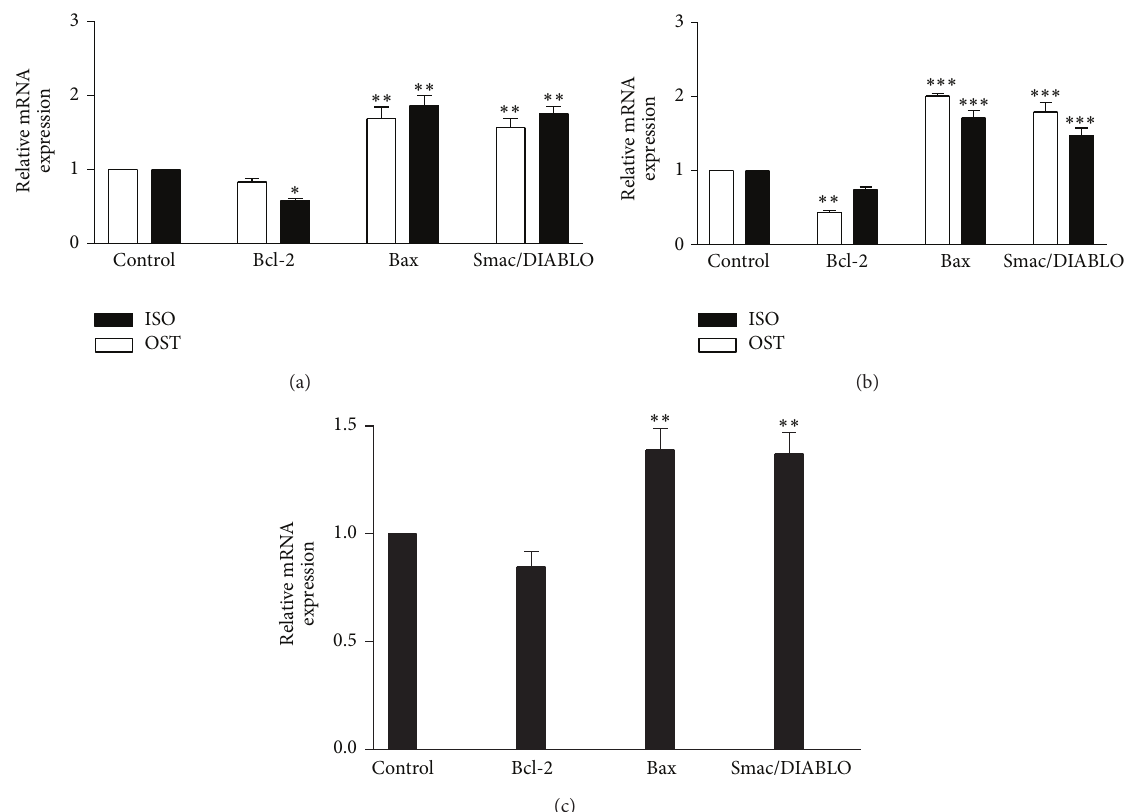
Figure 4: The effect of coumarins on expression of apoptotic-related genes on (a) SKNMC, (b) PC3, and (c) H1299 human cancer cells. Normalization relative to b-actin was performed. Levels of mRNA are expressed relative to control in the mean ± S.E.M values derived from three independent experiments. ∗ 𝑃 < 0.05 , ∗∗ 𝑃 < 0.01 , and ∗∗∗ 𝑃 < 0.001 versus